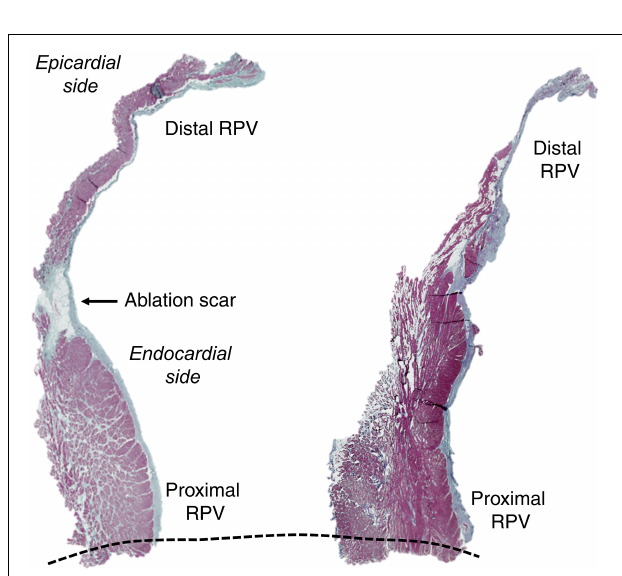
of attempts inducing AF ( Figure 4A ). In high LA